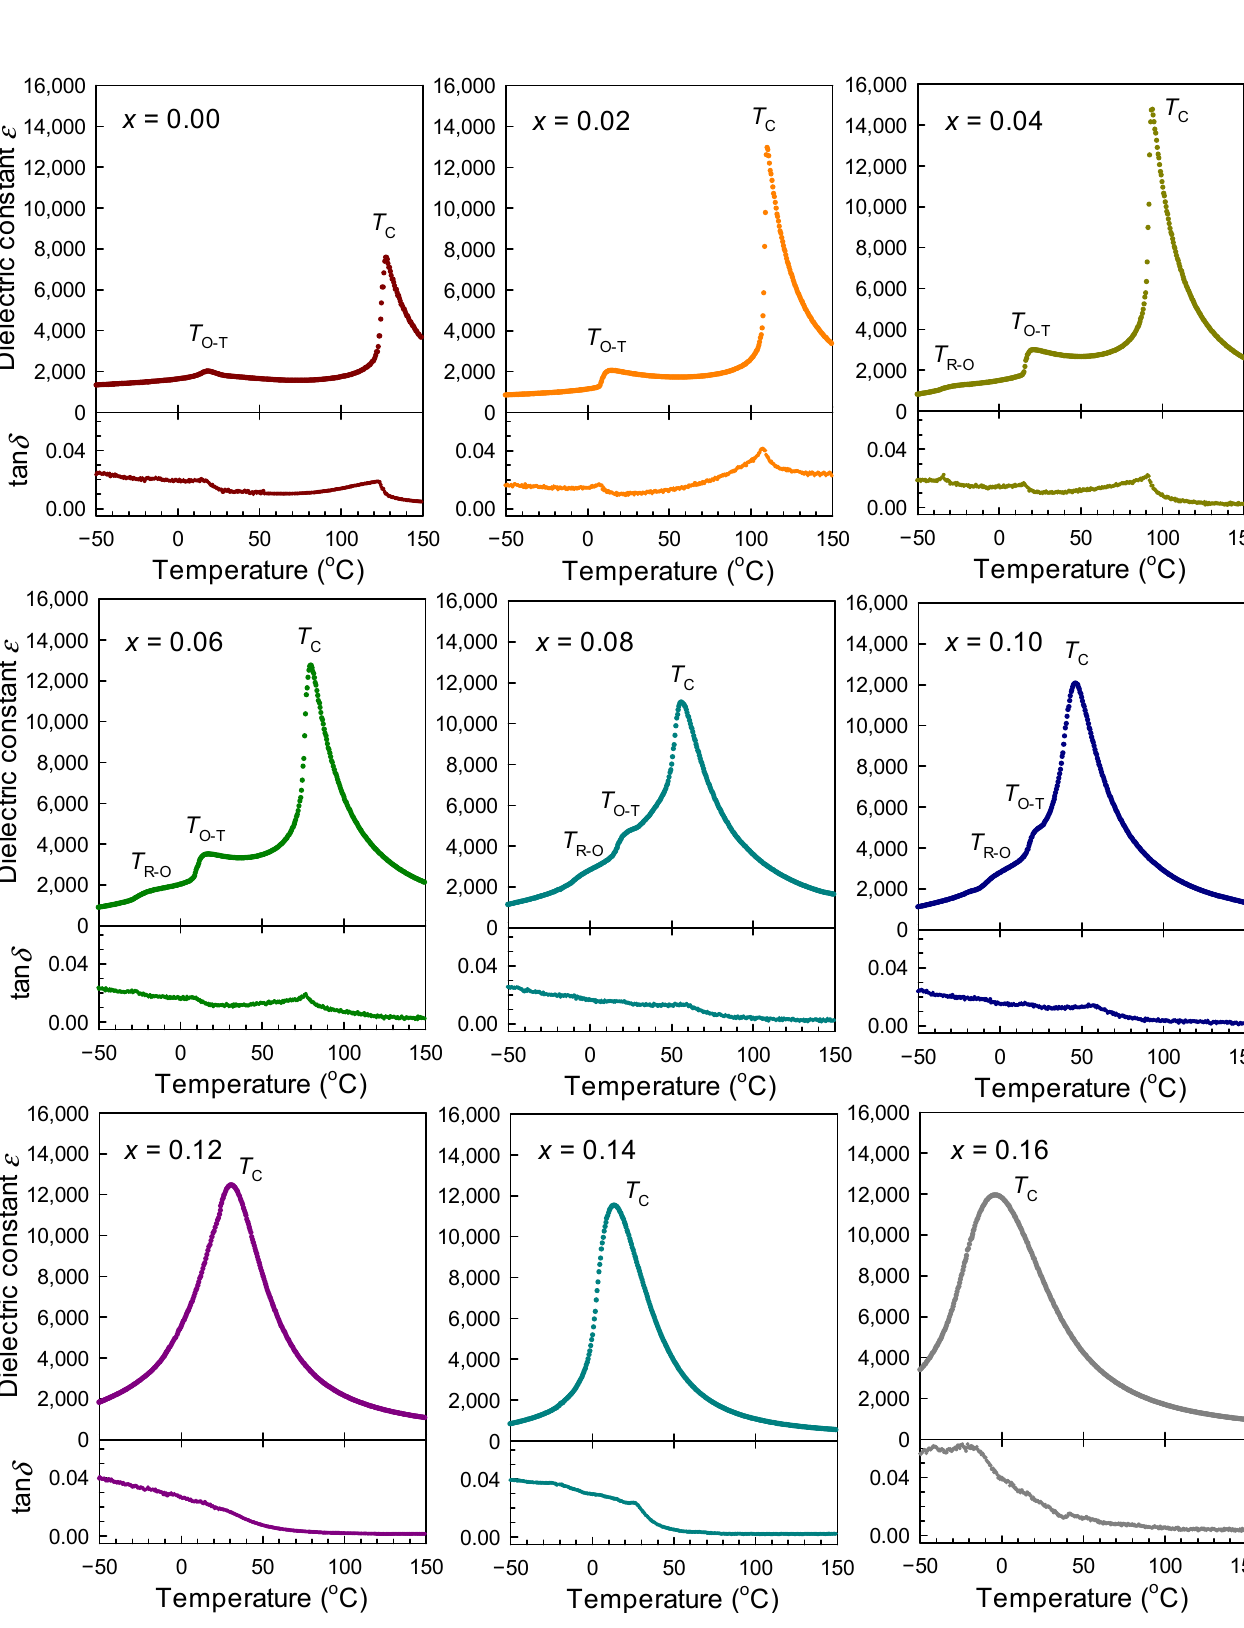
Figure 3. Temperature-dependent dielectric constant ε and loss tan δ of BT- x CS (0.00 < x < 0.16) measured at 100 kHz. Table 1. Dielectric properties and phase transition temperatures of BT- x CS.